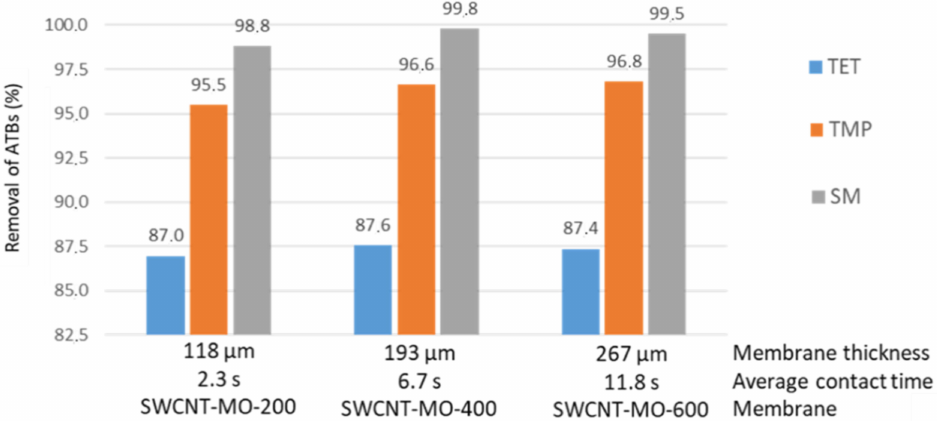
Figure 12. Rate of removal of ATBs for different membrane thicknesses versus average contact time.